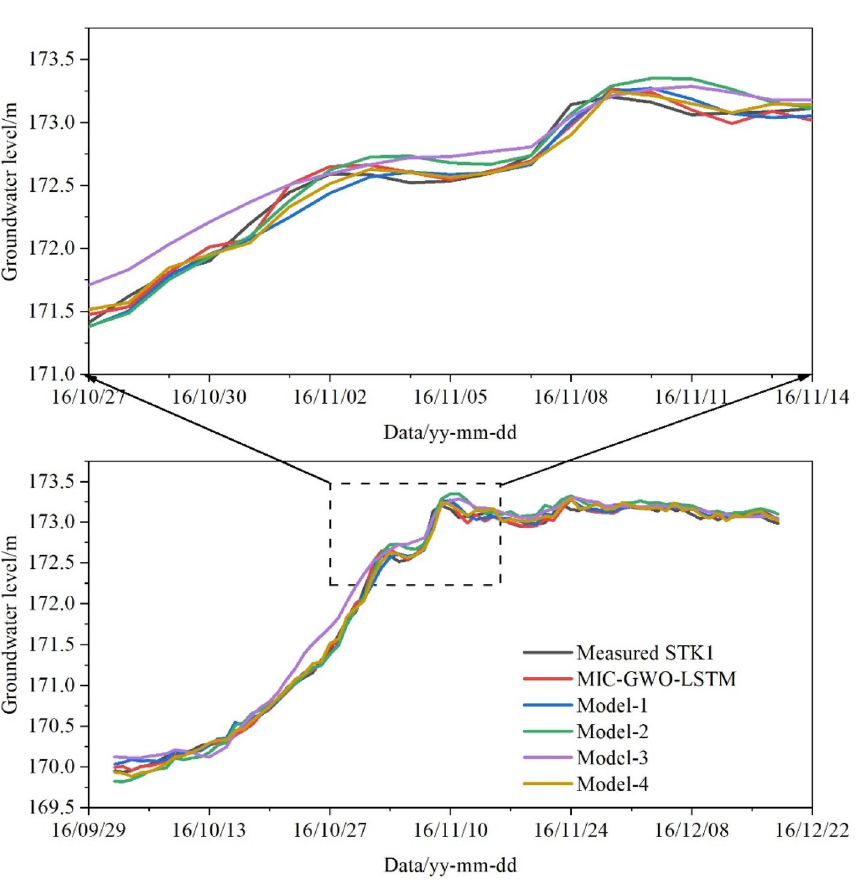
Figure 18. Prediction results under different triggering factors of the test